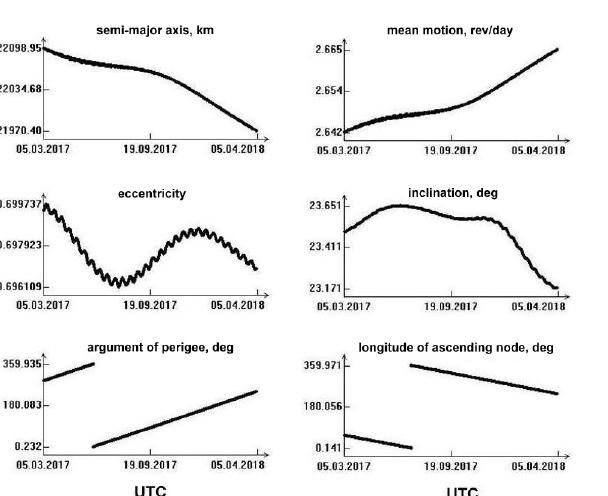
Figure 7. Residuals in the right ascension (top) and declination (bottom) in arcsec for 99995